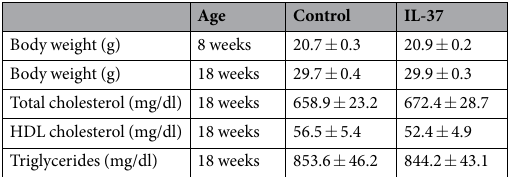
Table 1. Body weight and lipid levels in all groups. Note: Values are presented as the mean ± SEM, n =